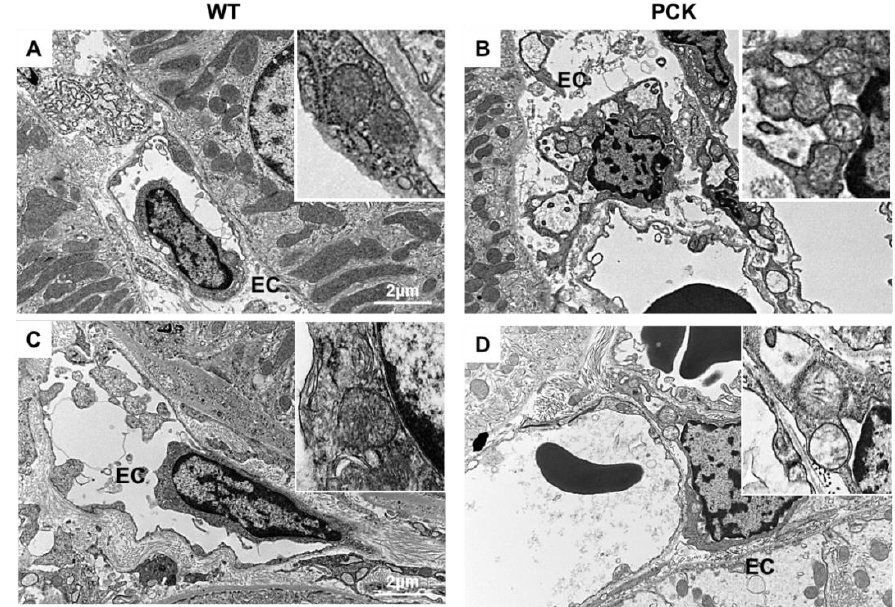
Figure 3. PKD is associated with mitochondrial structural abnormalities in endothelial cells. TEM displaying representative peritubular capillary endothelial cells (EC) from WT (left column) and PCK (right column) kidneys at 4 and 12 weeks (( A , B ) and ( C , D ) respectively). In PCK, peritubular capillary EC exhibited morphological abnormalities (cristae remodeling and loss) not only in the capillaries surrounding cystic structures but also in the capillaries surrounding normal appearing tubules (×2500 and ×80,000).